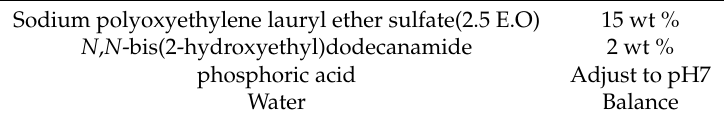
Table 2. Formulation of Shampoo (pH